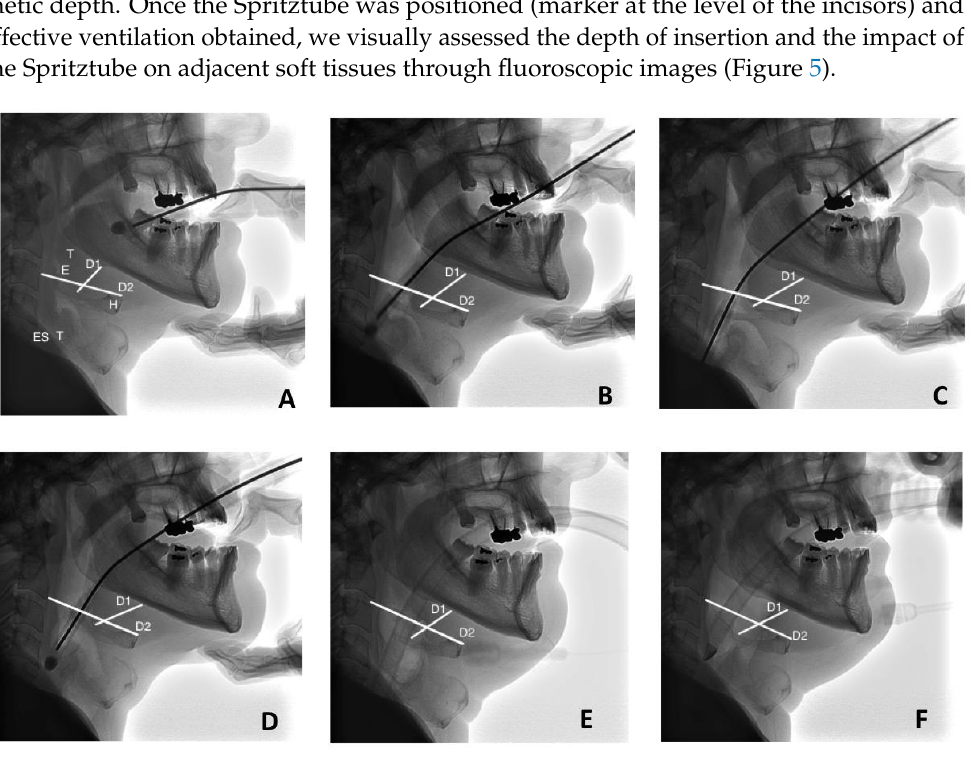
Figure 5. Radiological Localisation of Spritztube (ST) as extraglottic device. Dash lines are used to